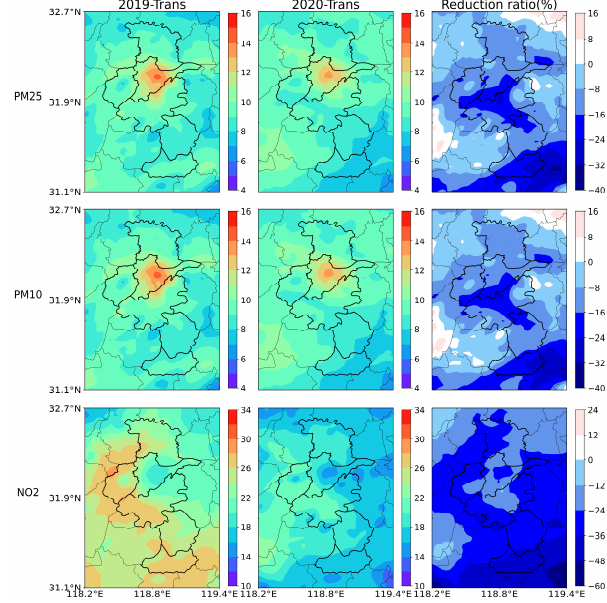
Figure 11. Spatial distribution of average NO 2 , PM 2.5 , and PM 10 concentrations ( µ g/m 3 ) and reduction ratio of near-surface traffic emissions during the NP and LP in the Nanjing City model simulation.